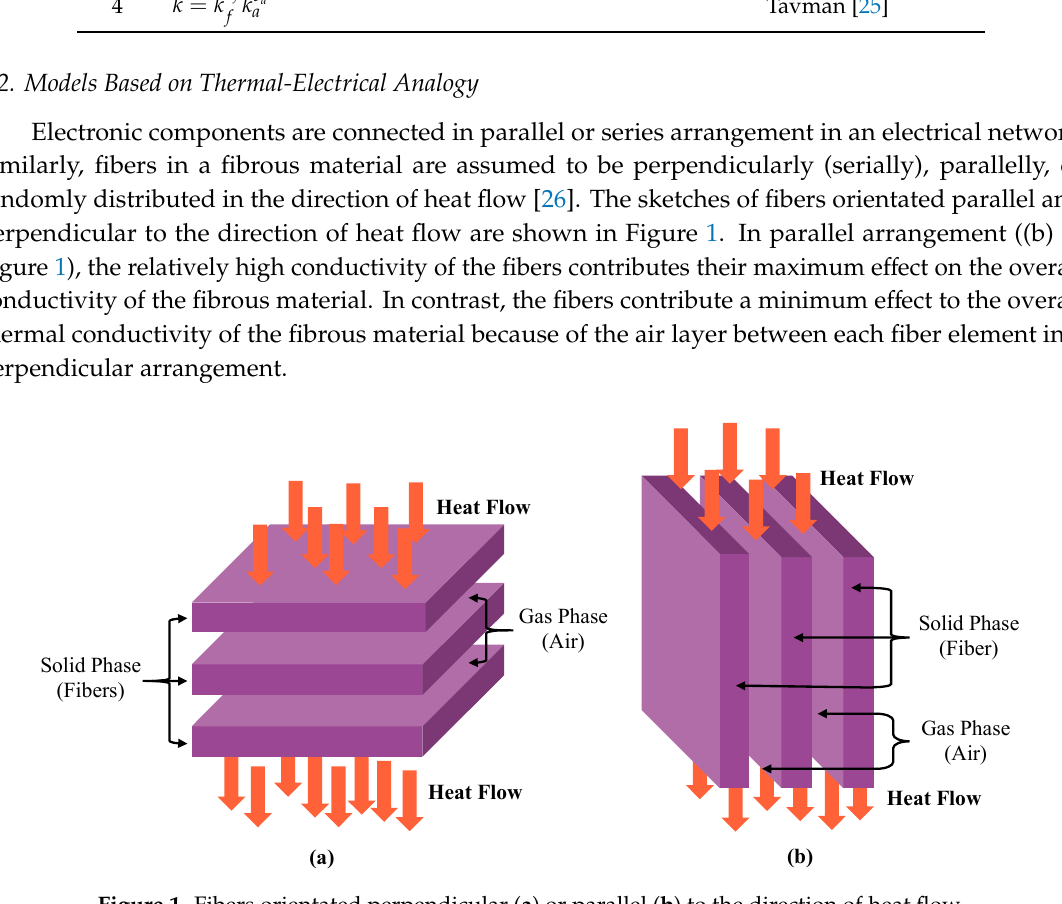
Table 2. Some models for fibrous material with parallel, perpendicular, and random fiber orientations.